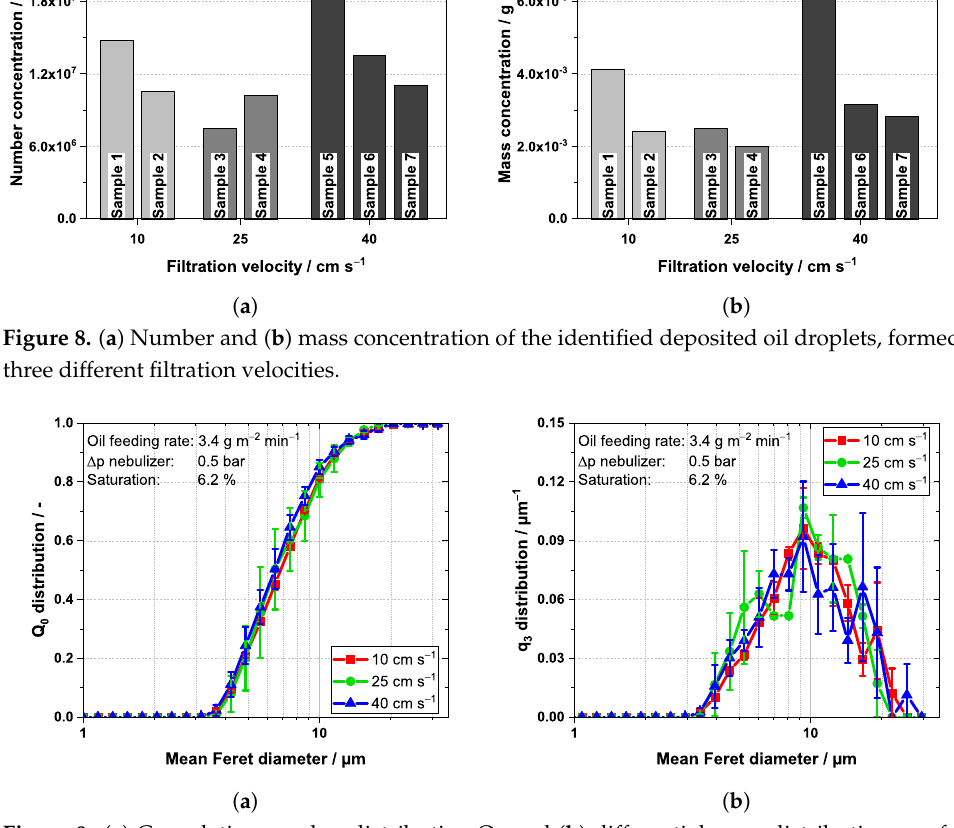
Figure 9. ( a ) Cumulative number distribution Q 0 and ( b ) differential mass distribution q 3 of the deposited oil droplets. Error bars indicate the standard